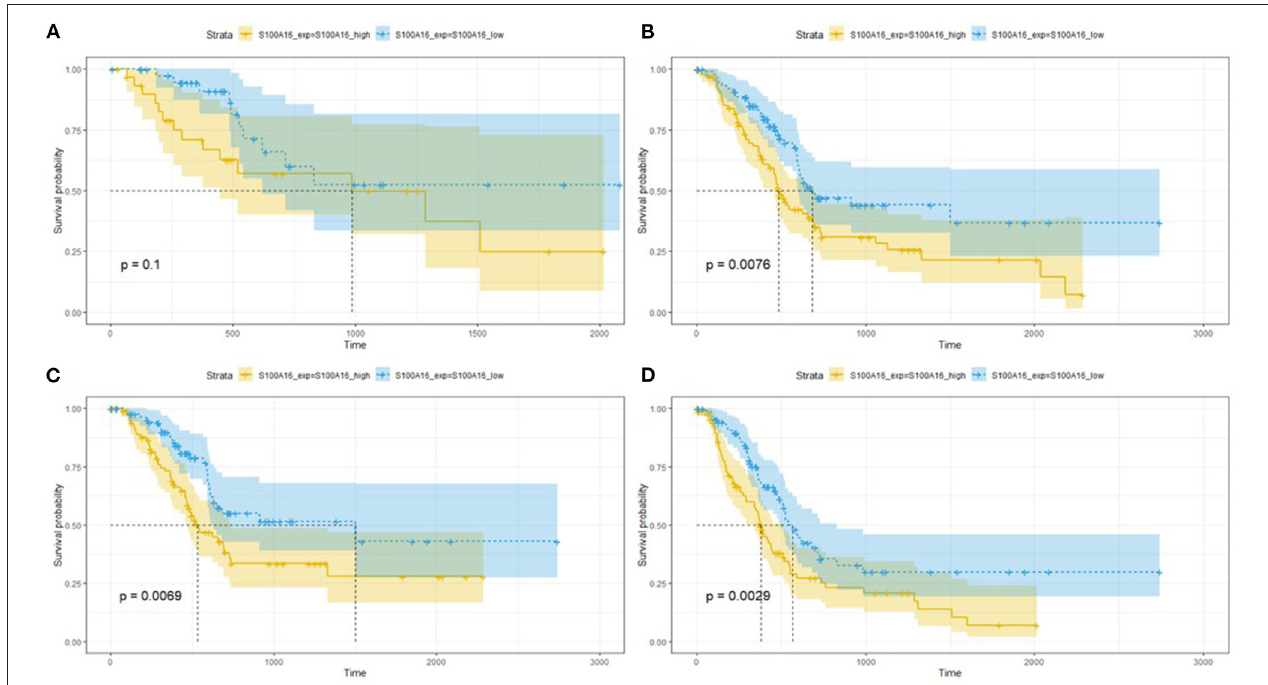
FIGURE 10 | Relationship between S100A16 expression levels and survival rate in PC as analyzed by Kaplan-Meier (A–D) . The relationship between survival probability and S100A16 expression level.